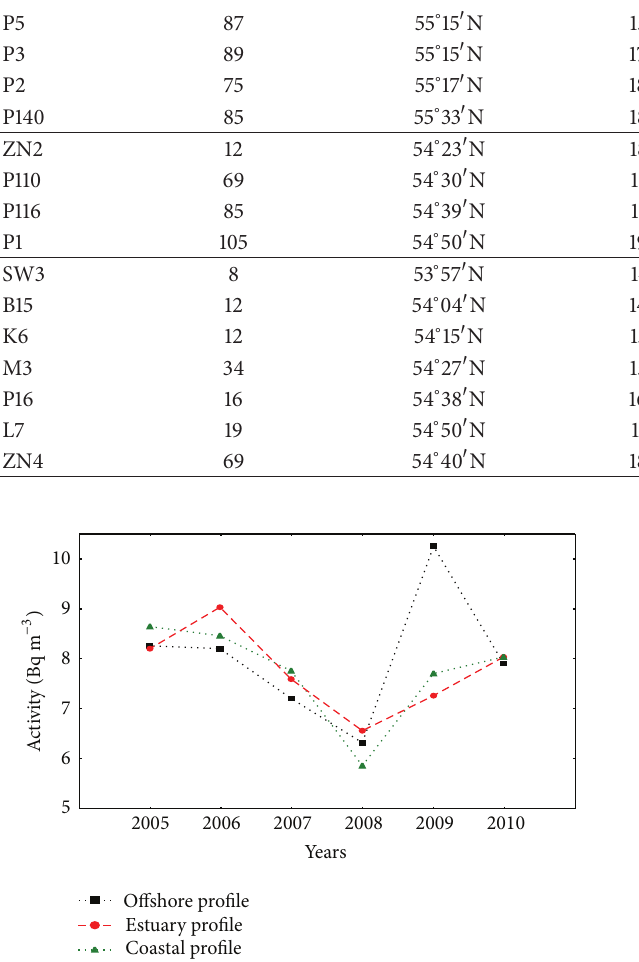
Figure3:Averageactivitiesof 90 SrinseawaterofthesouthernBaltic